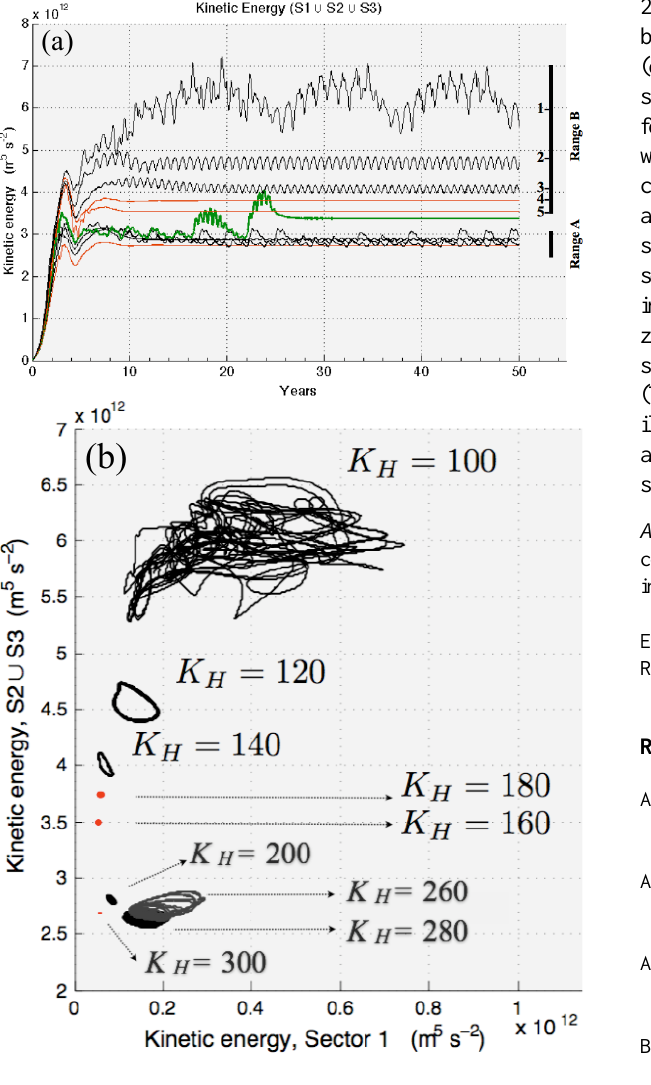
Fig. 9. (a) Time series of the kinetic energy integrated in sec- tor S1 ∪ S2 ∪ S3 for different values of K H : K H = 100, 120, 140, 160, 180, 200, 220, 240, 260, 300m 2 s − 1 , corresponding to lines 1,...,10, respectively. Two different energetic regimes (Range A and Range B) can be identified; the green line ( K H = 200m 2 s − 1 ) marks the transition between them. The red lines identify steady states of the system. (b) Orbits projected onto the (kinetic en- ergy)(S1) − (kinetic energy) (S2 ∪ S3) plane for different values of K H